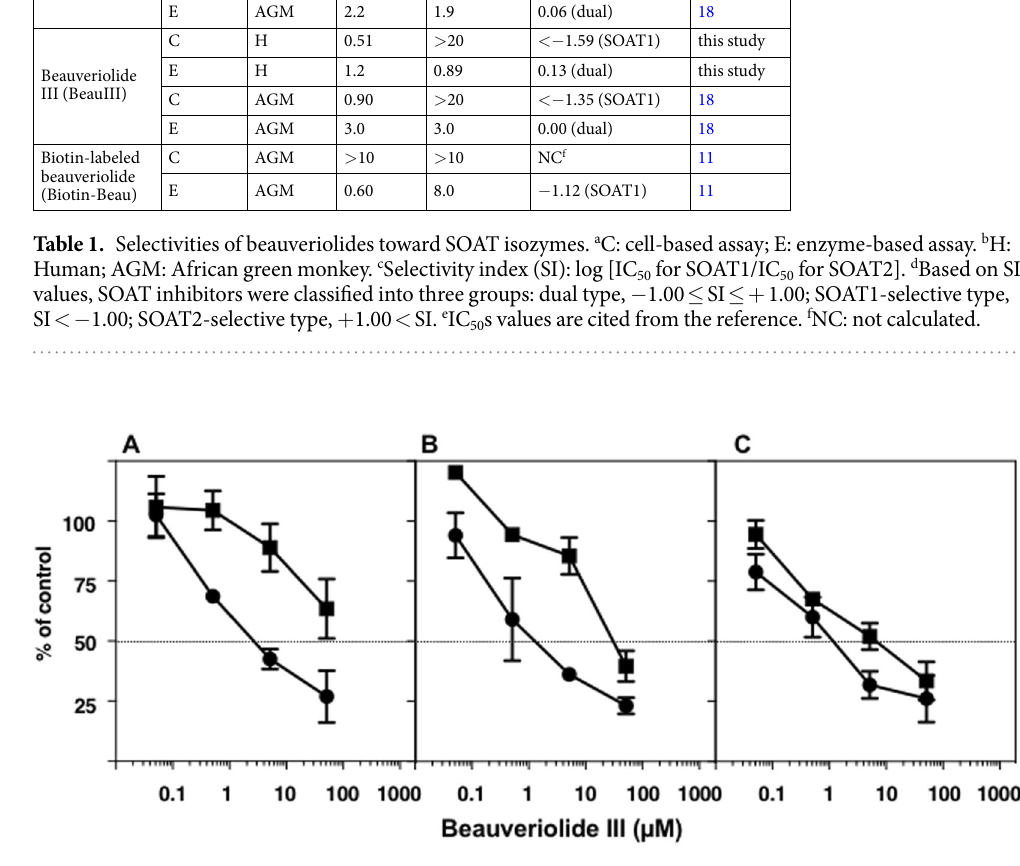
Figure 2. Inhibition of SOAT1 and SOAT2 by BeauIII in an enzyme-based assay using microsomes from SOAT1- and SOAT2-CHO cells disrupted by sonication. SOAT1-/SOAT-CHO cells were sonicated for 3 ( A ), 5 ( B ), and 10 min ( C ). Microsomes were prepared from the disrupted cells, and used as enzyme sources for the SOAT1 ( ● ) and SOAT2 ( ■ ) assays. The results obtained were plotted as % of control (without drugs). Values represent means ± SD (n =